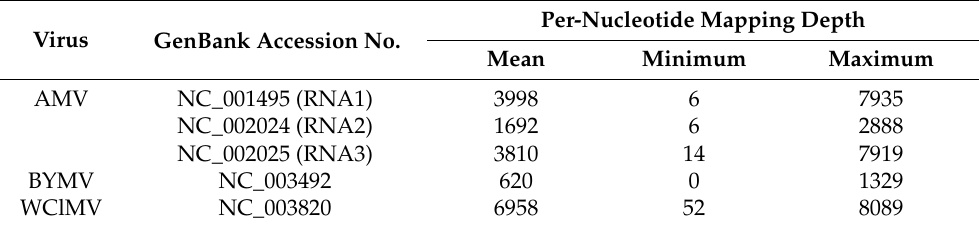
Table 11. Viruses identified in sweet pea by Oxford Nanopore sequencing showing the level of coverage. Virus GenBank Accession